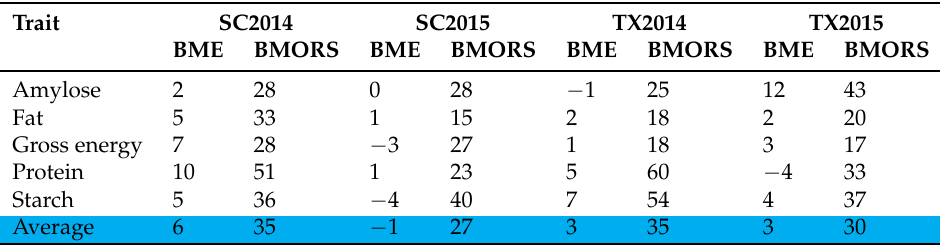
Table 3. Percent change in mean prediction accuracy (r) over the single trait single environment (STSE) model in the recombinant inbred lines (RILs). BME: Bayesian multi-environment, BMORS: Bayesian multi-output regressor stacking, SC: South Carolina, and TX: Texas. Values were rounded to the nearest whole number.